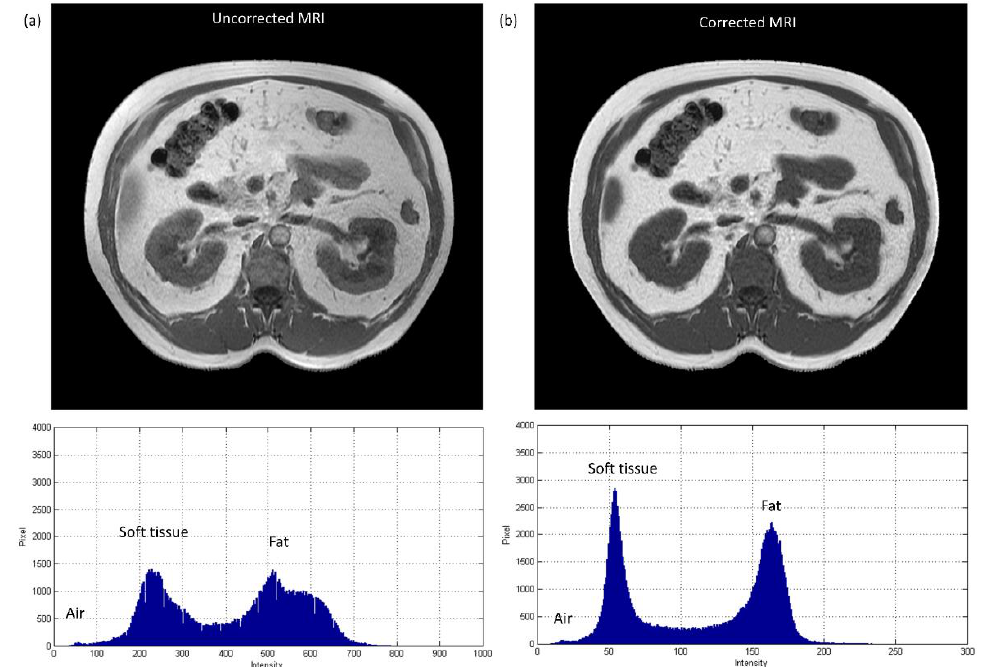
Figure 10. Axial image and histogram of ( a ) uncorrected MRI (WL/WW = 375/750) and ( b ) corrected MRI (WL/WW = 125/250) from 1.5 T scanner for abdominal imaging belonging to CNN testing dataset ( IMG testingabdomen ).